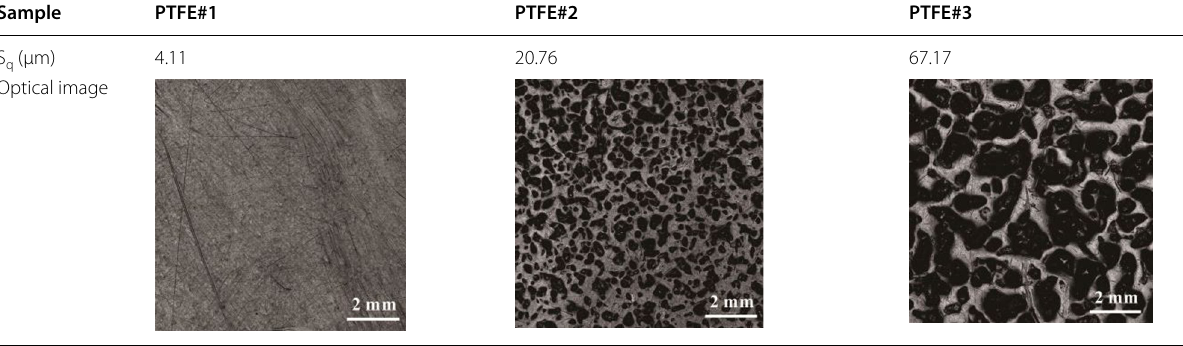
and optical images q